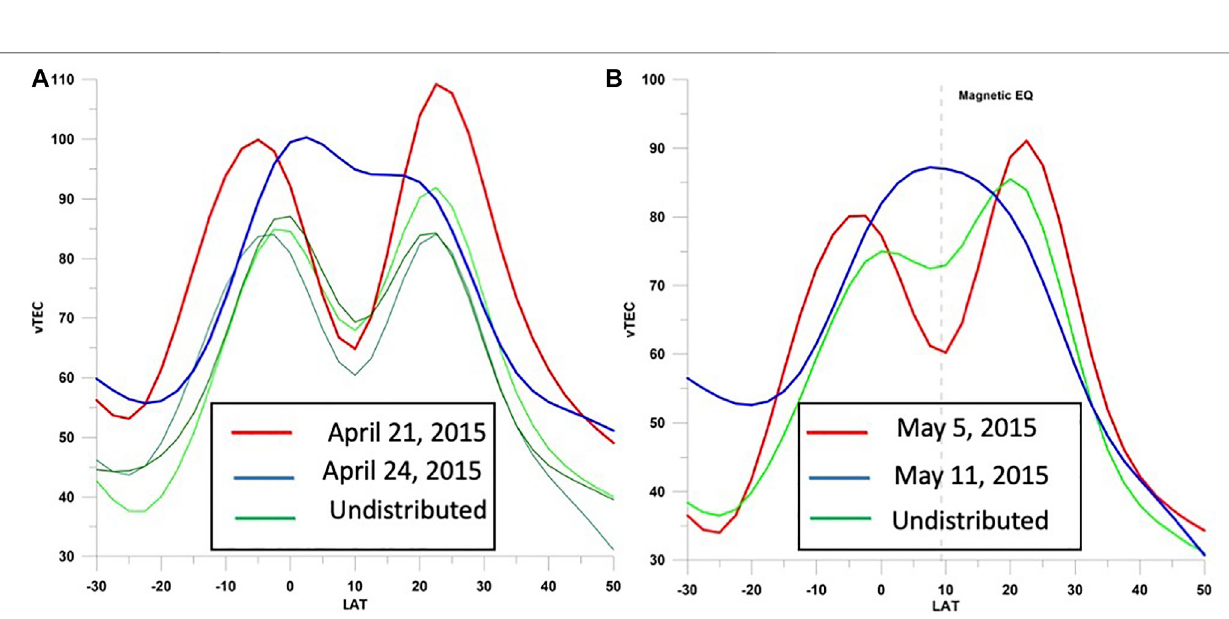
Frontiers in Earth Science |